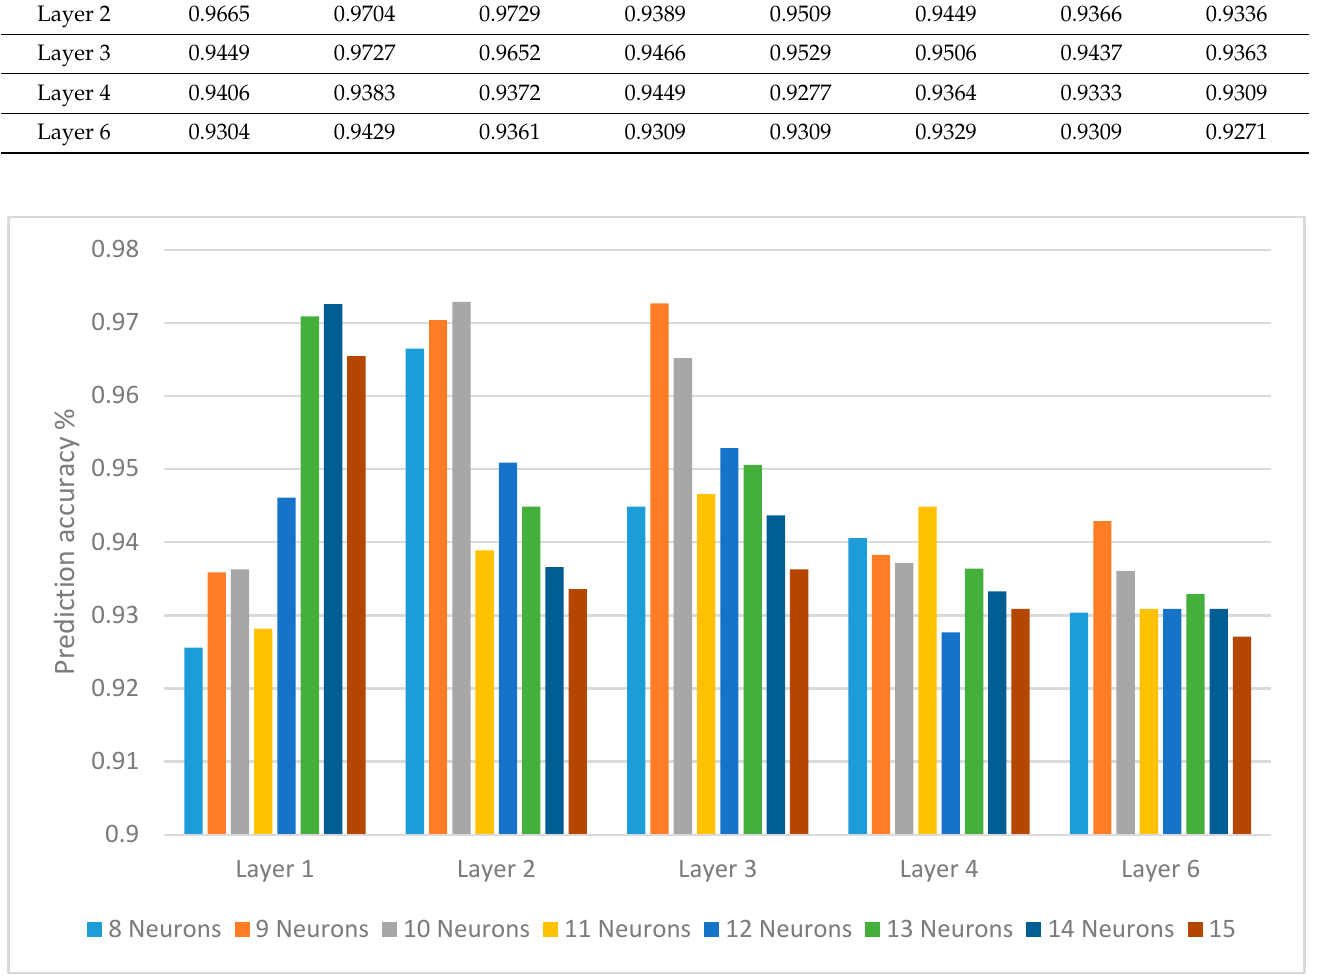
Figure 5. Prediction accuracy of various counts of neurons in convolutional layers.